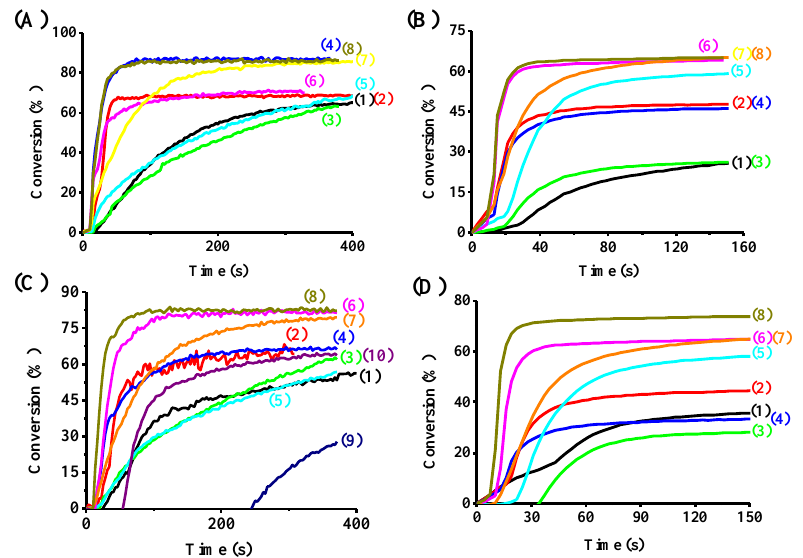
Figure 5. Free radical photopolymerization profiles of acrylate functions vs. irradiation time in: ( A ) thick samples @455 nm, ( B ) thin sample @455 nm, ( C ) thick sample @405 nm and ( D ) thin sample @405 nm: (1) Cu1/Iod (0.1%/1% w / w ), (2) Cu2/Iod (0.1%/1% w / w ), (3) Cu1/Iod (0.2%/1% w / w